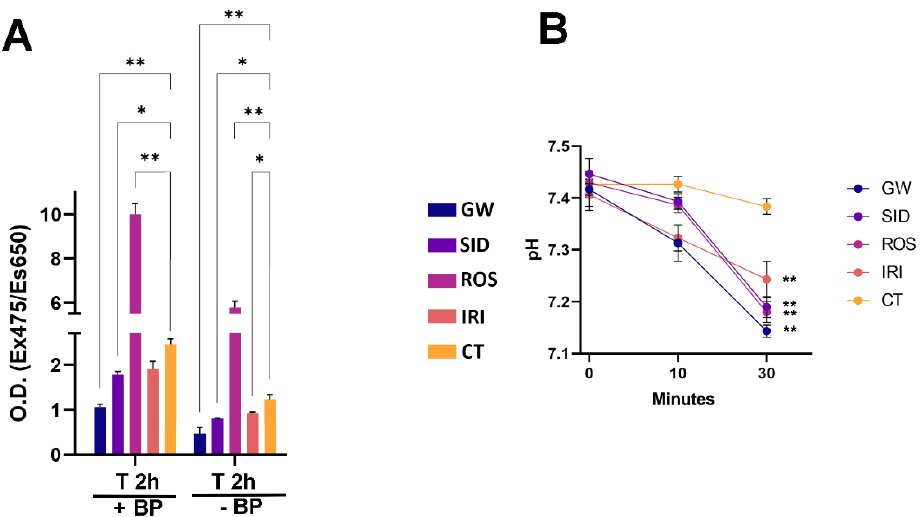
Figure 5. Uptake and release of FFAs in MSCs treated with browning agents after white adipogenic differentiation. ( A ): the cells were serum-starved for 16 h, then treated with 10 µM BODIPY FL C16 for 2 h in DMEM (T 2 h + BP). Subsequently, cultures were incubated for 2 h (T 2 h w/o BP) with complete medium (DMEM containing 10% FBS) without BODIPY FL CL16. The histogram shows the uptake levels of palmitate in different experimental conditions. ( B ): Cells were incubated in KREBS buffer with 2%BSA for 10 min, then the pH of the medium was evaluated at 10 and 30 min following the addition of 0.5 µg/mL epinephrine in the medium. Data are expressed as optical density (O.D Ex475/Es650 nm) (±SD, n = 3 biological replicates; * p < 0.05, ** p < 0.01). GW: GW501516; SID: sildenafil; ROS: rosiglitazone; IRI: irisin; CT: differentiated white adipocytes without analyzed drugs. Drug concentration: 1 nM (GW); 1 nM (SID); 43 nM (ROS); 20 nM (IRI).